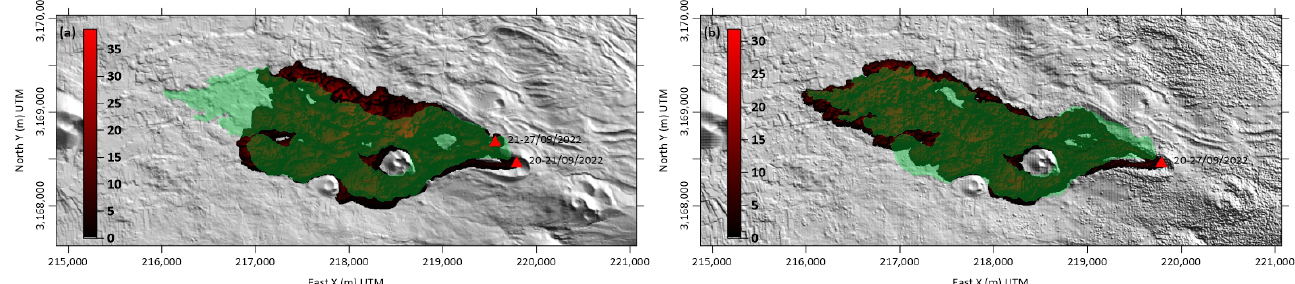
Figure 8. Representation of the lava emplacement on 27 September (in green) and the one obtained from the simulation (SS7 in ( a ) and SS8 in ( b ), from Table 2) performed until that day with the parameters calibrated in the simulation over fewer days. Values in colour legend are lava thicknesses in metres. The background image shown in each figure corresponds to the DEM or DSM used in each simulation